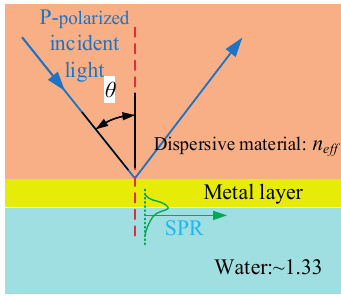
Figure 3. The simplified SPR excitation model of the SPR sensor.